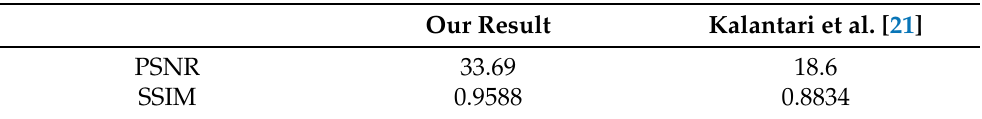
Table 4. For comparison with Kalantari et al. [21], we evaluate the average PSNR and SSIM for all images in the